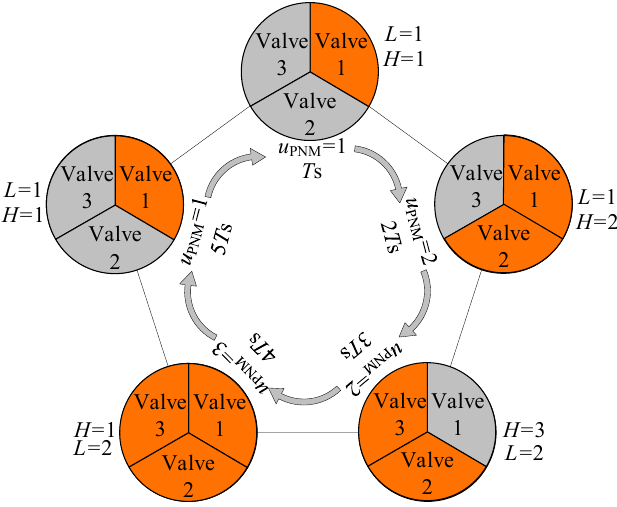
Figure 13. Optimization strategy of PNM coding signal.